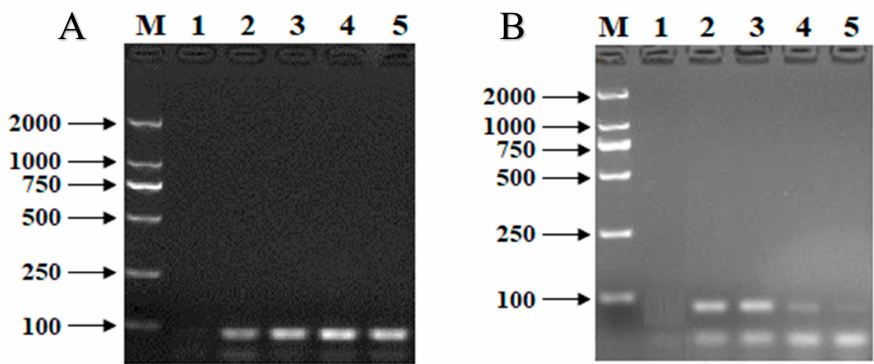
Figure 1. Verification of the biosensor system. ( A ) Ligation reaction between DNAzyme and ligation- dependent probe. M: DL 2000 (DNA marker); 1: negative control; 2–3: DNAzyme ligation reaction. ( B ) Cleavage of the substrate chain of DNAzyme Cu 2+ addition. M: DL 2000 (DNA marker); 1: nega- tive control; 2–3: in the absence of Cu 2+ ; 4–5: in the presence of Cu 2+